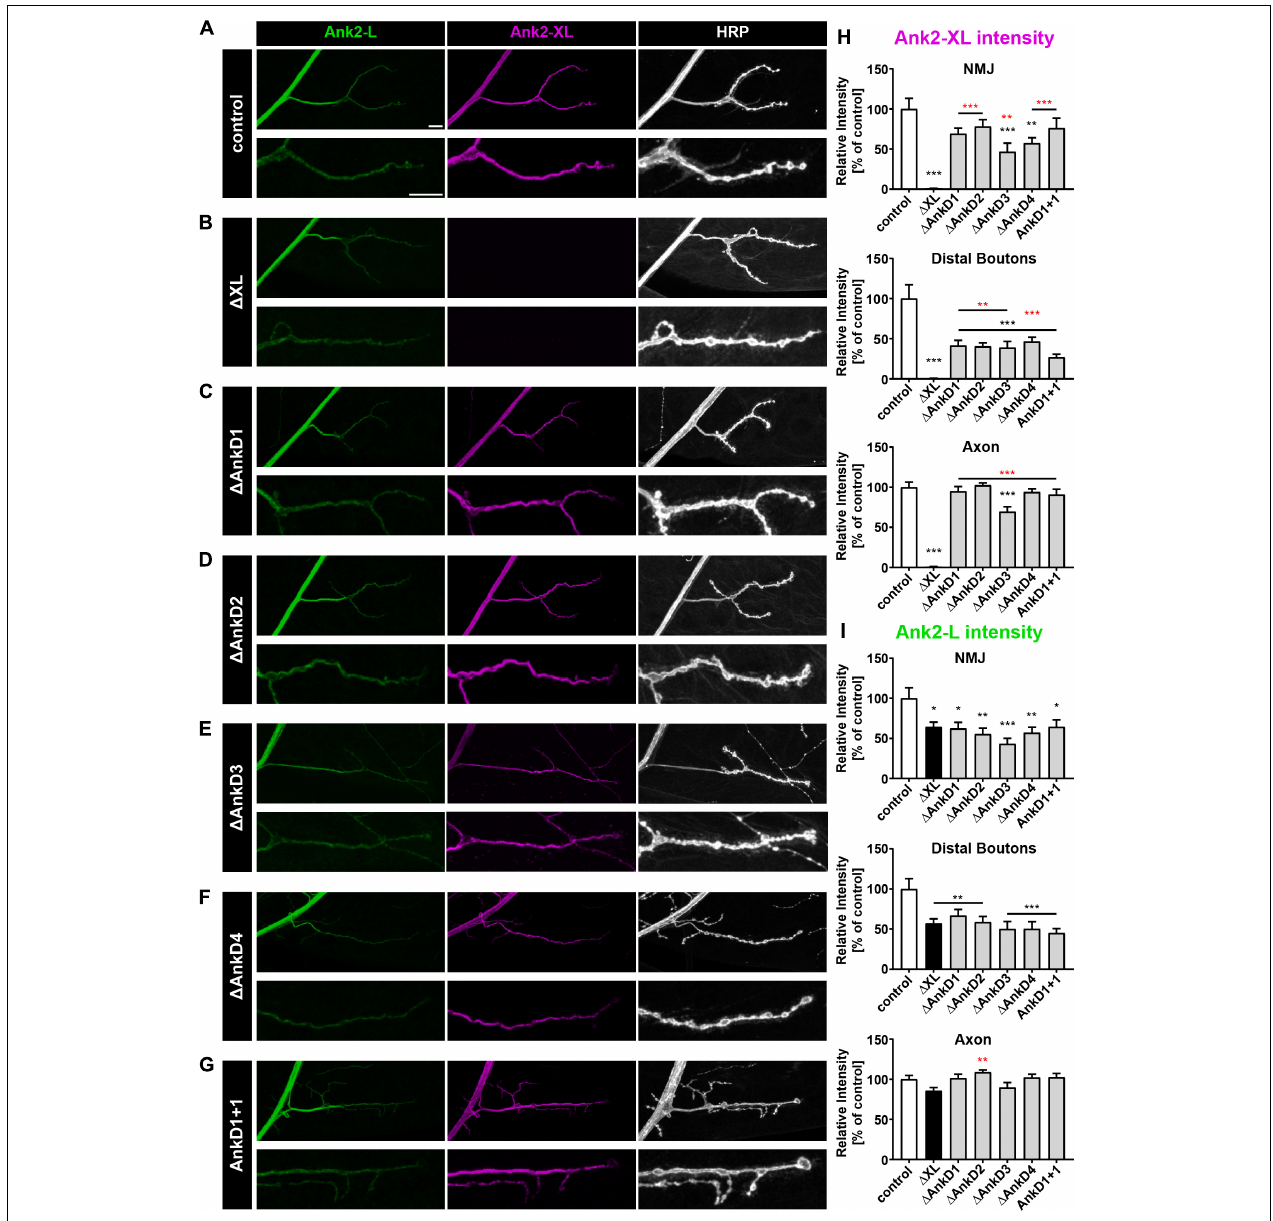
FIGURE 4 | Analysis of ARD-dependent localization of Ank2-L and Ank2-XL in ank2 (cid:49) XL mutants. (A–G) Analysis of Ank2-L (green) and Ank2-XL (magenta) localization at muscle 4 NMJs (HRP, white). (A) In control animals ( P[ank2_wt] /+; ank2 (cid:49) XL /ank2 (cid:49) XL ) levels of Ank2-L and Ank2-XL are restored compared to ank2 (cid:49) XL mutants. (B) In ank2 (cid:49) XL /ank2 (cid:49) XL mutant animals Ank2-XL is absent and levels of Ank2-L are slightly reduced at the NMJ but not in the axon. (C–G) Analysis of the AnkD manipulations ( P[ank2_ (cid:49) AnkDx] /+; ank2 (cid:49) XL /ank2 (cid:49) XL ) reveals reductions of Ank2-L and Ank2-XL level at the NMJ. Ank2-XL levels are significantly reduced in the axon and NMJ when the third AnkD was deleted. (H) Quantification of Ank2-XL level at the NMJ, within distal boutons and in the axon ( n = 12 muscle 4 NMJs, three animals/genotype). (I) Quantification of Ank2-L level at the NMJ, in distal boutons and in the axon ( n = 12 muscle 4 NMJs, three animals/genotype). Scale bars in (A) apply to (A–G) and represent 10 µ m. Error bars indicate SEM; ∗ p < 0.05, ∗∗ p < 0.01, ∗∗∗ p < 0.001 (ANOVA); black asterisks represent comparison to controls; red asterisks represent comparisons to ank2 (cid:49) XL